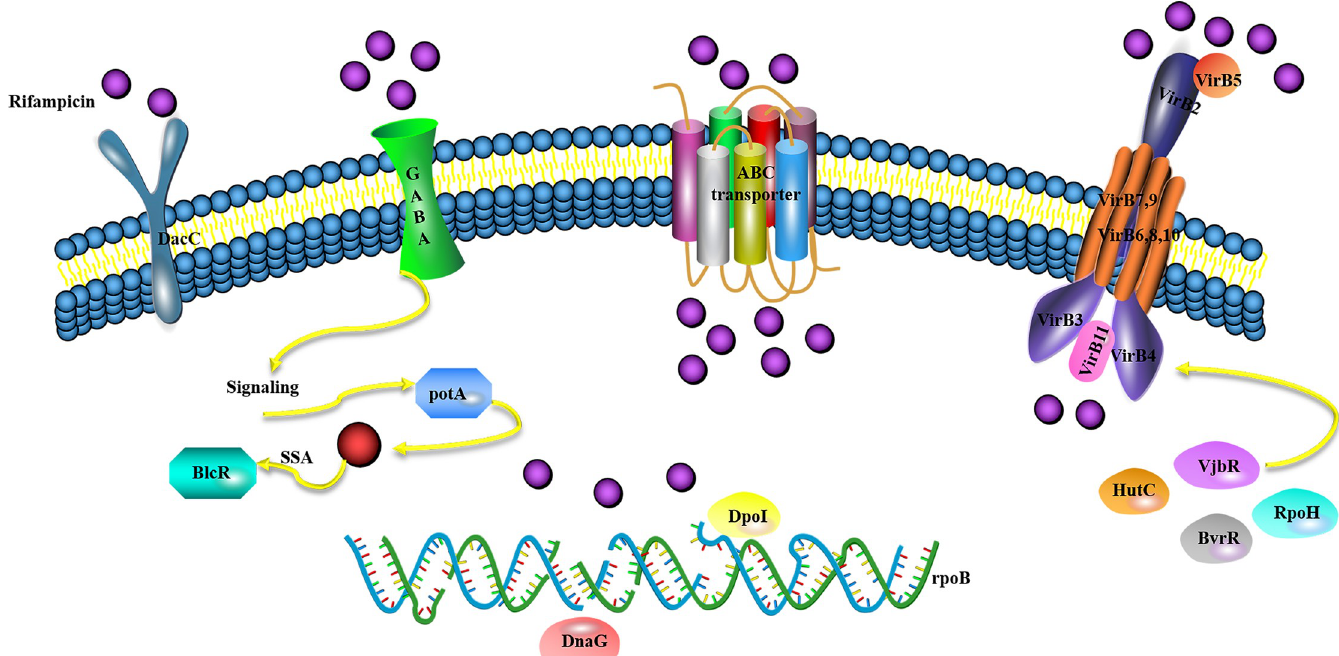
Fig 5. Hypothesis model of the rifampicin resistance mechanism in B . melitensis . https://doi.org/10.1371/journal.pntd.0008888.g005 VirB 7-11 gene deletion strains named BM Δ VirB 7- BM Δ VirB 11 were constructed in this study. The growth characteristics of the gene deletion and parent strains were determined in Brucella broth medium in 96-well plates. No significant variations were observed. The gene deletion and parent strains were cultured under different rifampicin concentrations. Under rifampicin conditions, all MIC values of the strains were not different. After 3 d, the MIC val- ues of the gene deletion strains were higher than those of the parent strain (Fig 6B). The There was no variation in rpoB during the culture by sequencing. We also constructed the virB 1-6 and virB 12 genes deletion mutants and named BM Δ VirB 1- BM Δ VirB 6 and BM Δ VirB 12. The growth characteristics of the gene deletion and parent strains were determined and no signifi- cant variations were observed. Under rifampicin conditions, all MIC values of the strains were not different compared with the parent strain.